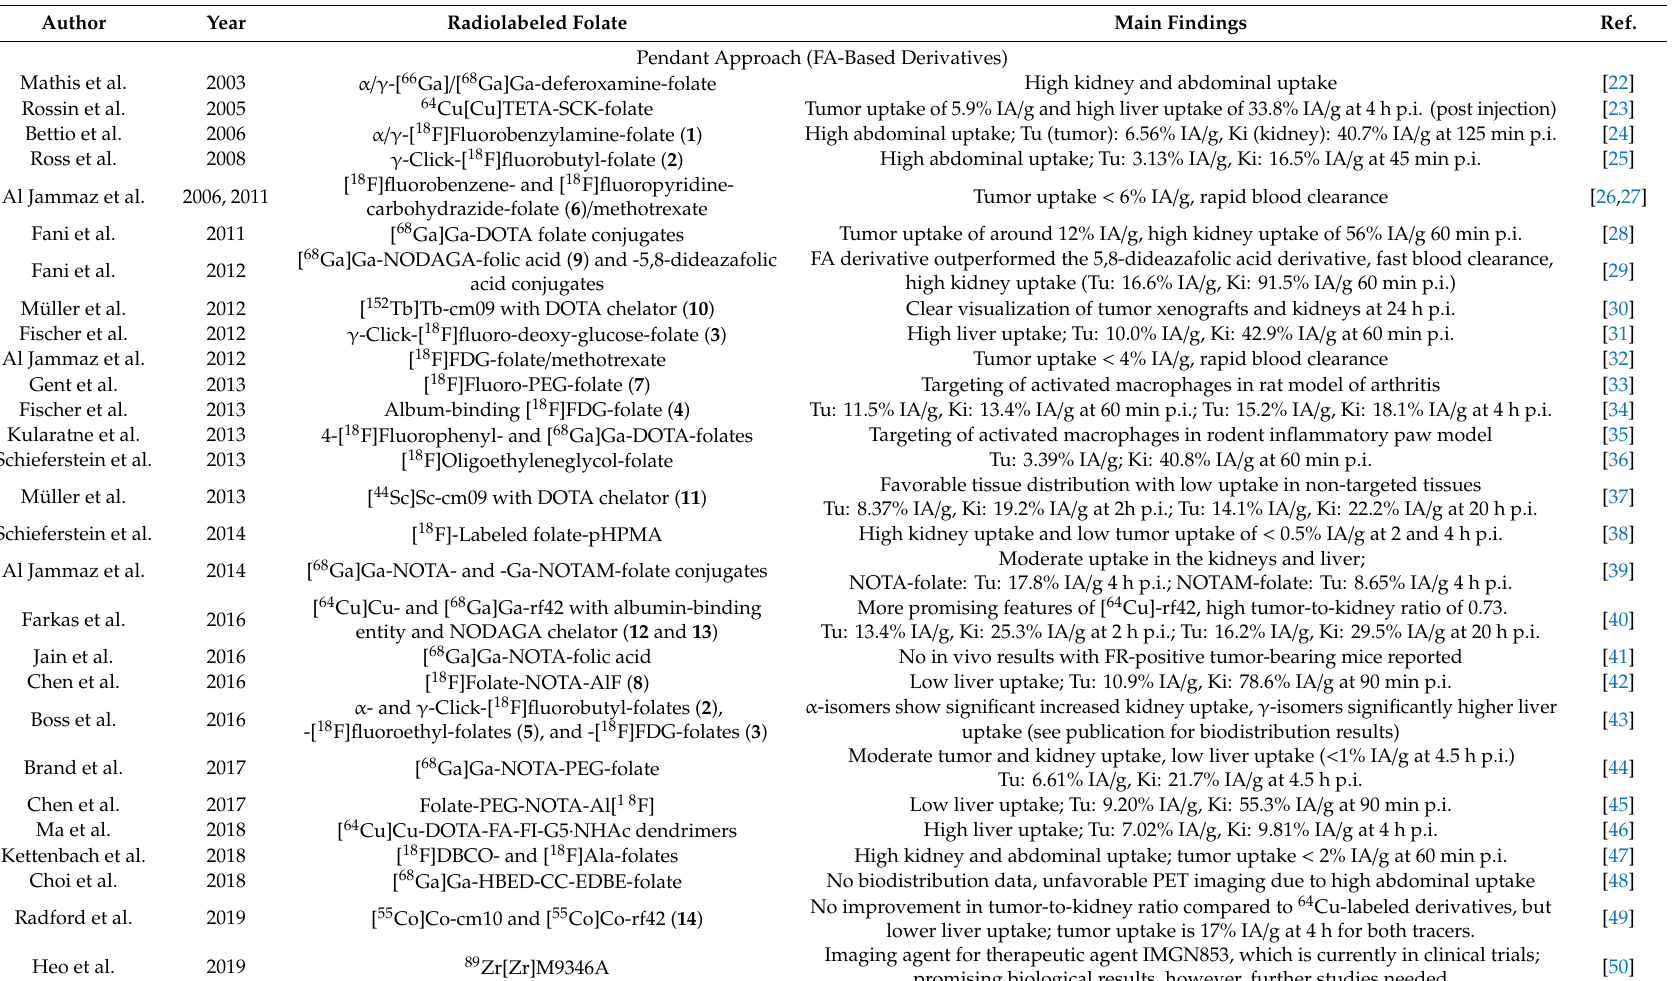
Table 1. Chronological development of PET (positron emission tomography) radiolabeled folate tracers for folate receptor (FR)-positive tumor